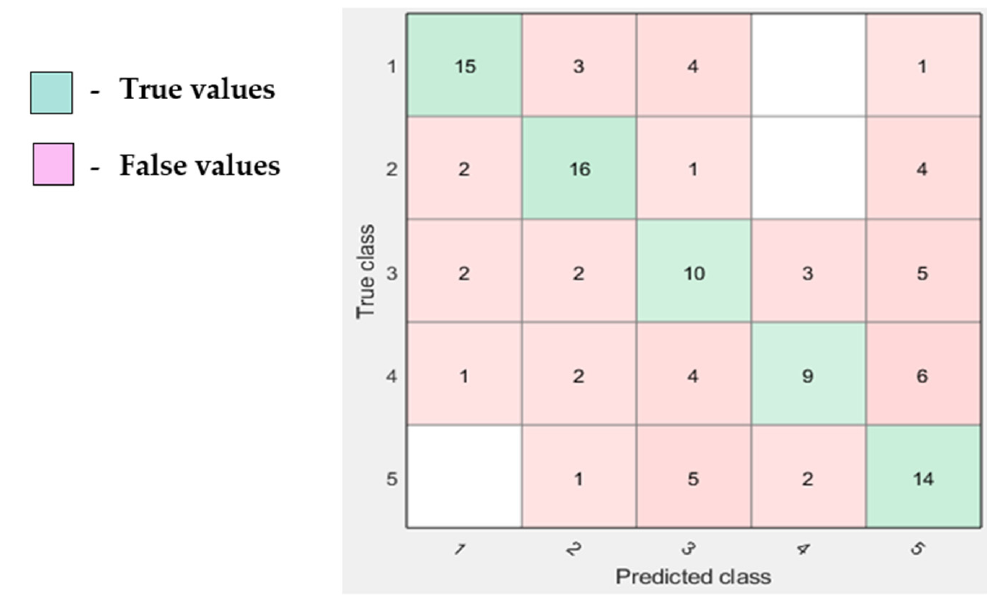
Figure 7. Confusion Figure 7 . Confusion matrix.